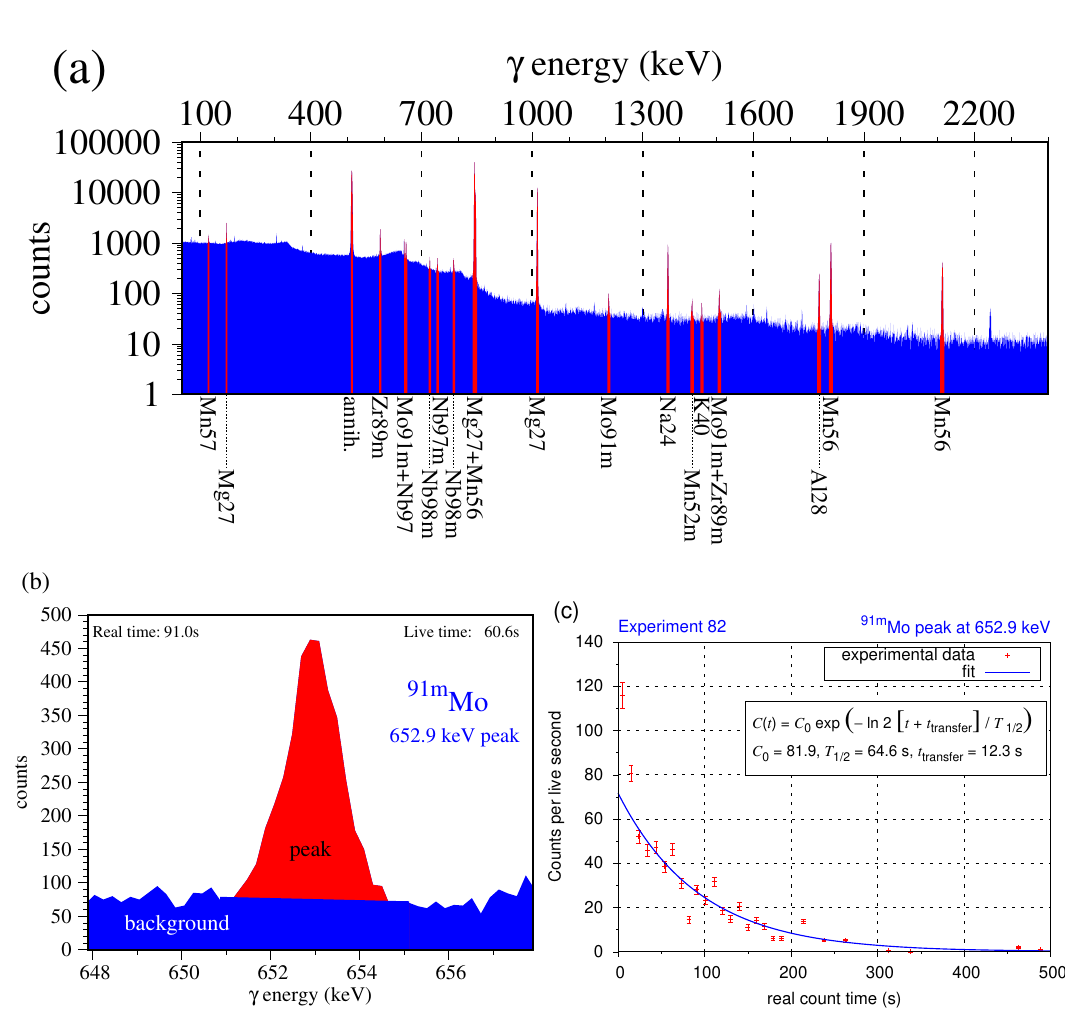
Figure 1: Experiment 82 γ spectroscopy. (a): final (end of ∼ 15-min. acquisition) integrated γ spectrum. (b): 652.9 keV peak associated with 91 m Mo after 91 s, showing the peak area after subtraction of the background. (c): counts as a function of time for this peak and the curve fitted to the data (see main text for details). C 0 is the dependent (free) variable. t transfer is the time delay between the end of the irradiation and the start of the γ -data acquisition – i.e. the transfer